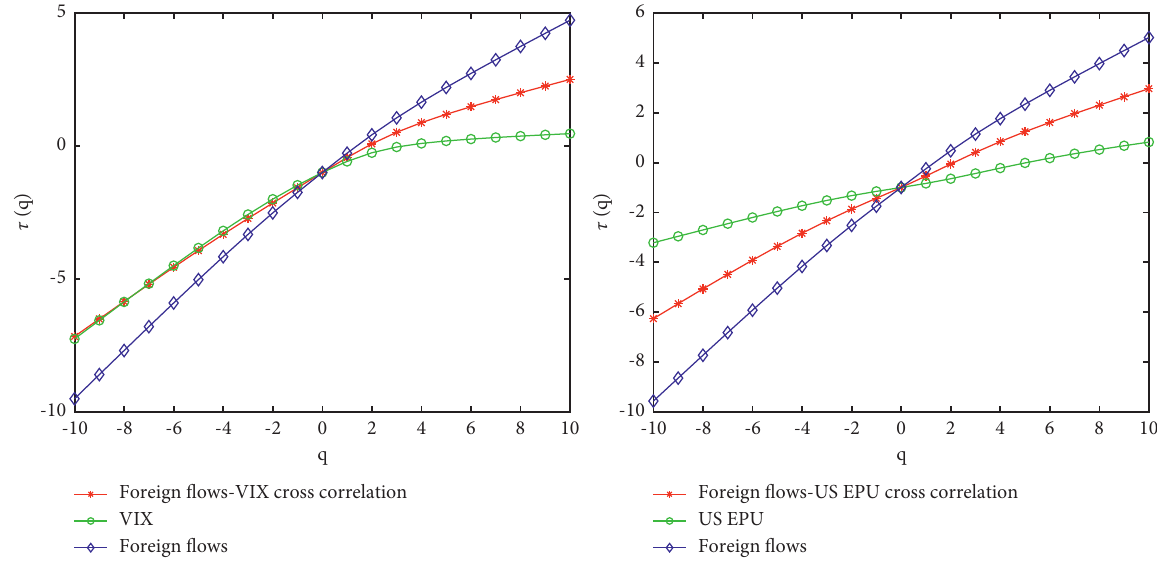
Figure 5: The Renyi exponent of τ ( q ) versus q for the foreign flows in A-share market and VIX and the foreign flows in A-share market and US EPU.